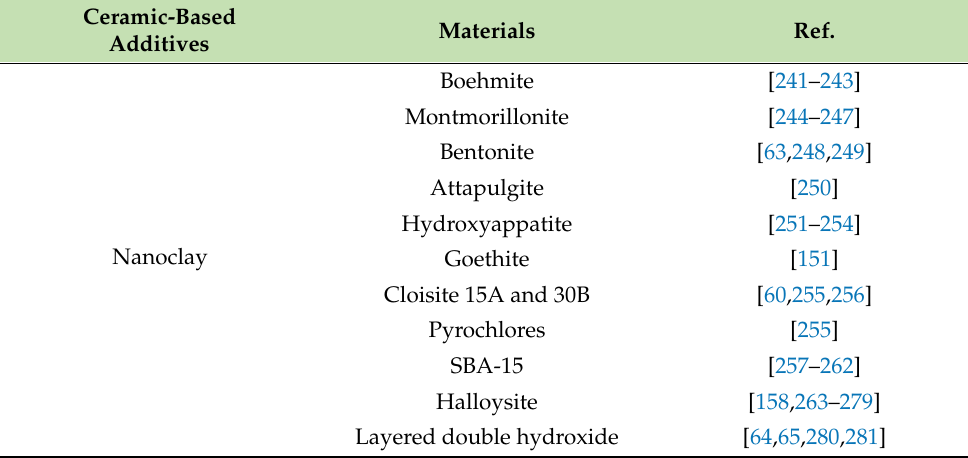
Table 3. Ceramic-based antifouling additives used in the last 10 years for the blending modification of polymeric